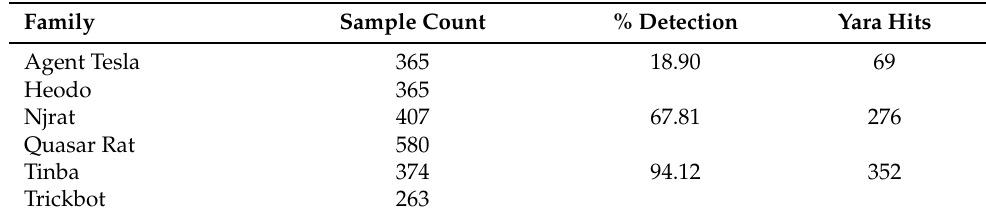
Table 9. Data Set 1 Yara